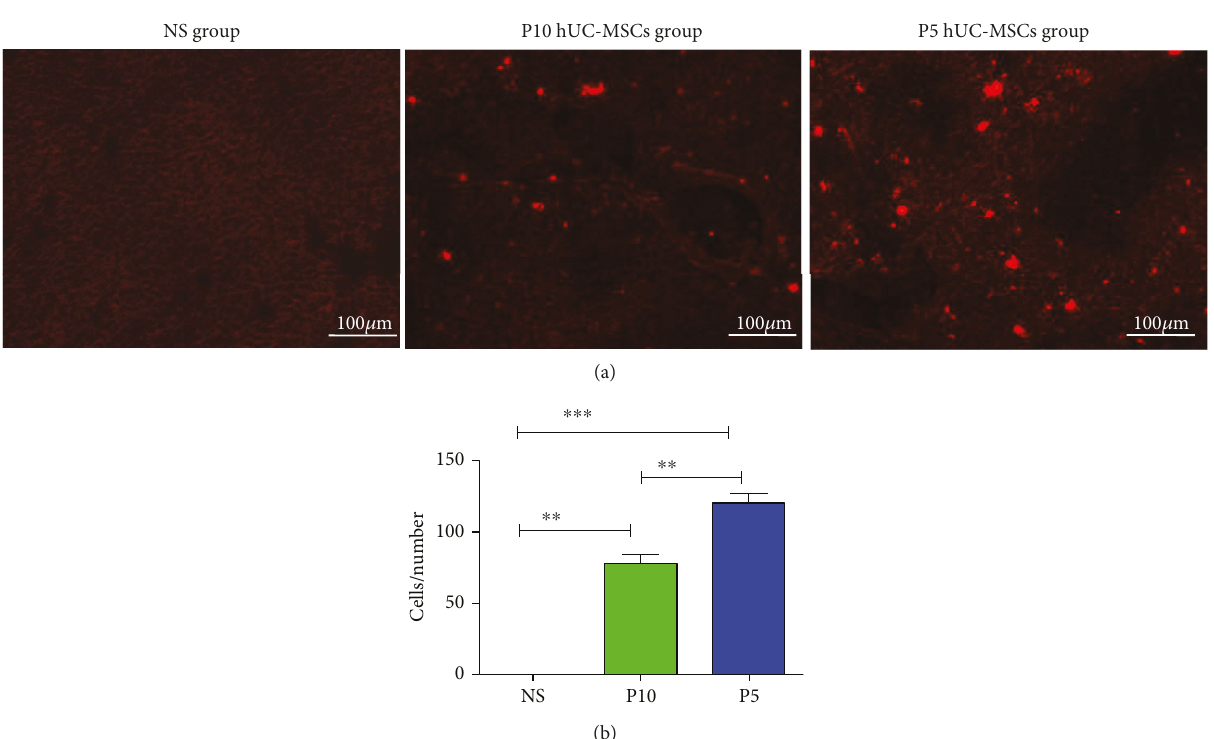
Figure 6: Infusion of CM-Dil-labeled hUC-MSCs enhances homing to livers D-GaIN/LPS-induced ALF at 48 h. (a) Liver sections were observed by fl uorescence microscope. Representative images from NS-treated, P10 hUC-MSC-treated, and P5 hUC-MSC-treated rats. Bar=100 μ m. (b) Quanti fi cation of the accumulated hUC-MSCs by Image-Pro Plus software. Data are reported as mean ± SD of the mean. ∗ P < 0 05 , ∗∗ P < 0 01 , ∗∗∗ P < 0 001 .